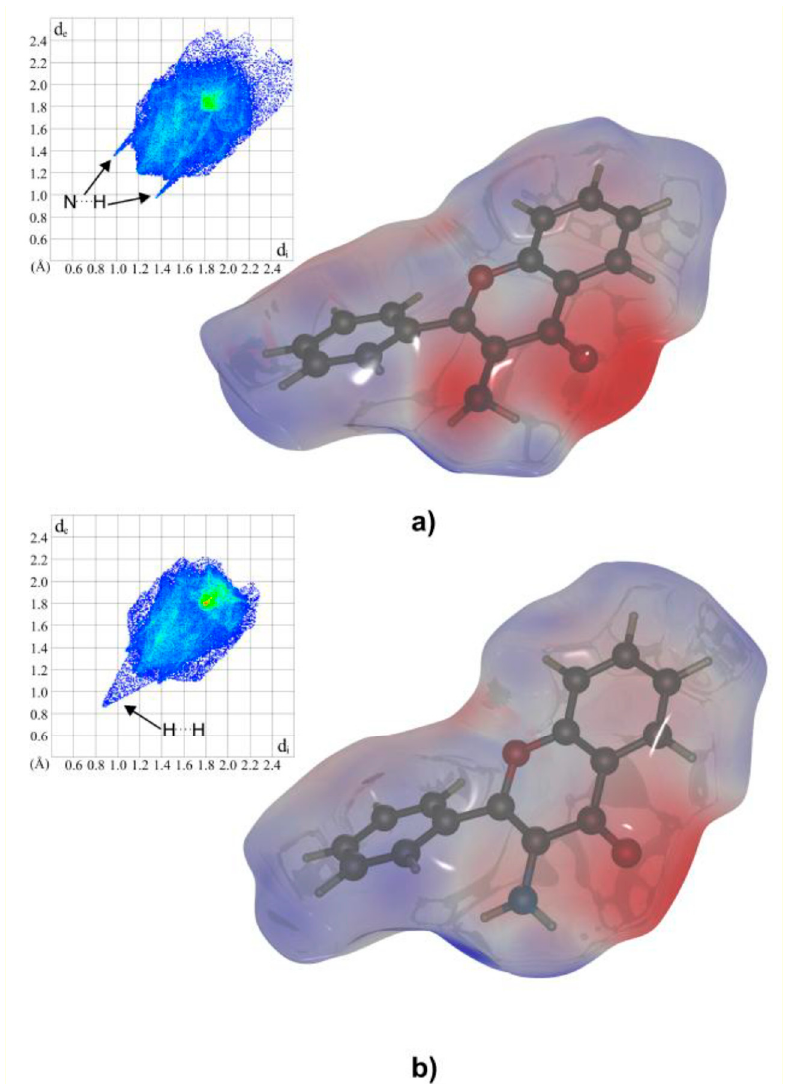
Figure 2. A view of 1o with atom numbering scheme. Displacement ellipsoids for non-hydrogen atoms were draw with 50% probability level—( a ); superposition of 3-AF molecules from crystal 1o (red) and centrosymmetric 1m (dashed green)—( b ).